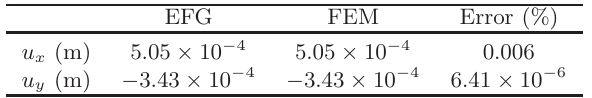
Table 3. Displacements for EFG and FEM methods of the laminated composite plate.